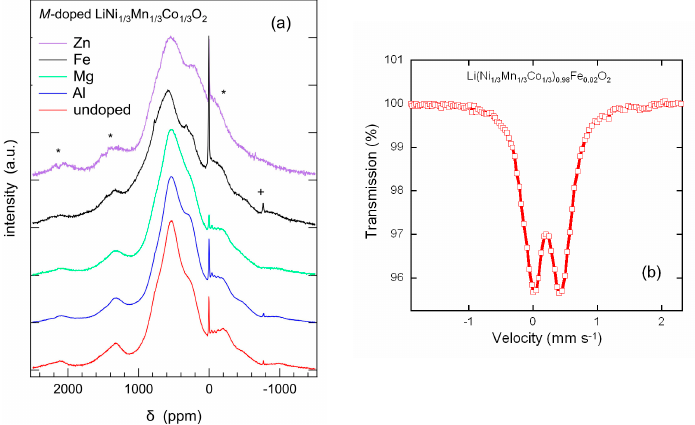
Figure 6. ( a ) 7 Li MAS NMR spectra of undoped and doped LiNi 1/3 Mn 1/3 Co 1/3 O 2 samples; ( b ) Fe Mössbauer spectrum of Li(Ni 1 / 3 Mn 1 / 3 Co 1 / 3 ) 1 − x Fe x O 2 Table 2. Deconvolution of sample spectra. Calculated areas include all significant sideband contributions.